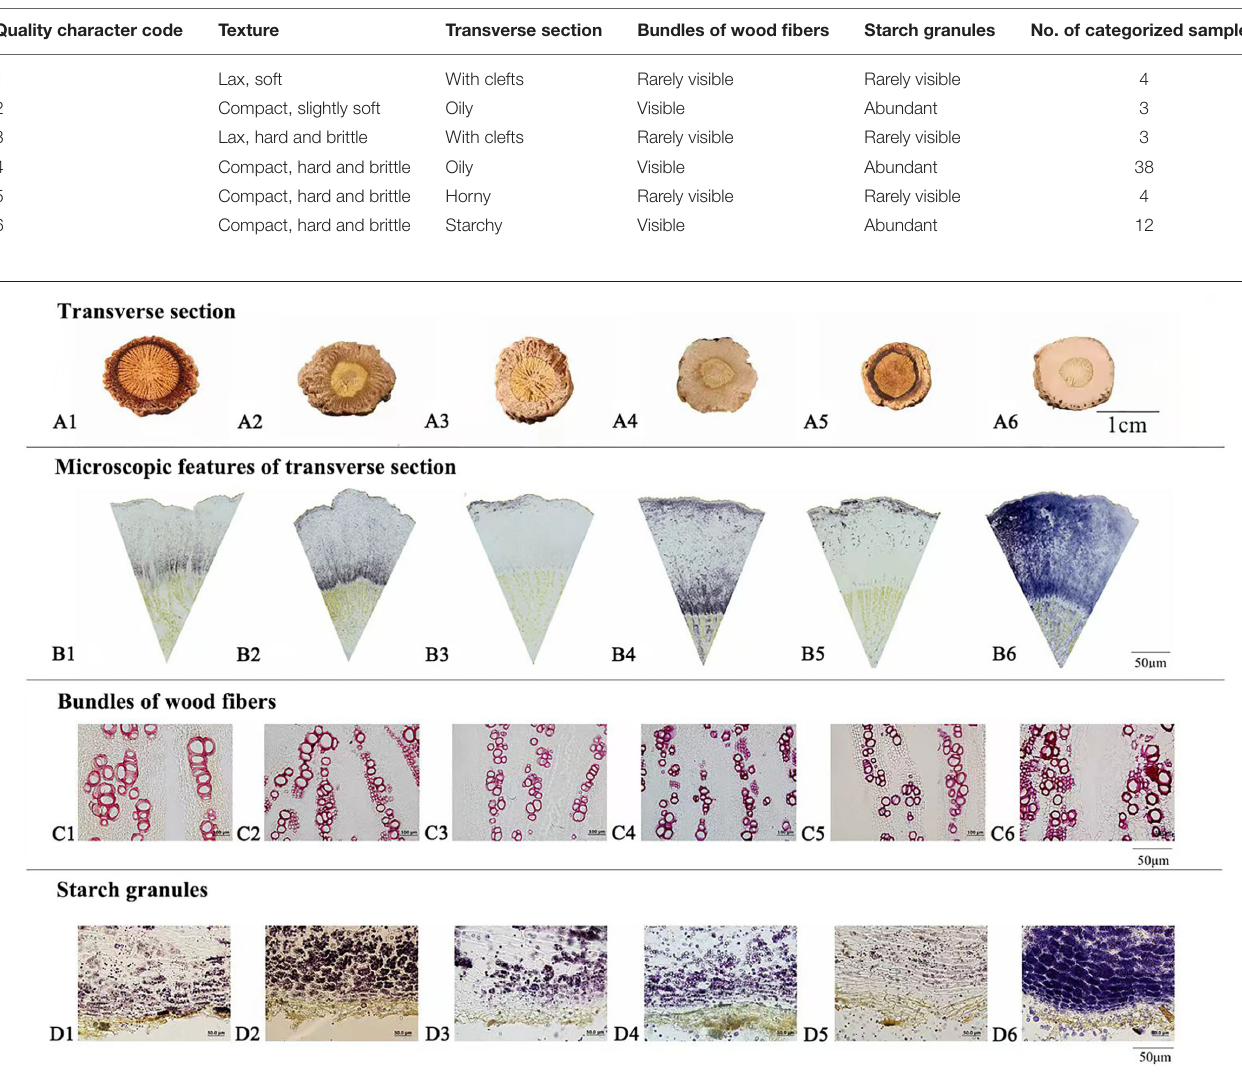
FIGURE 1 | Macroscopic features of transverse section (A) , microscopic features of transverse section (B) , bundles of wood fibers (C) , and starch granules (D) of Isatidis Radix with quality character code